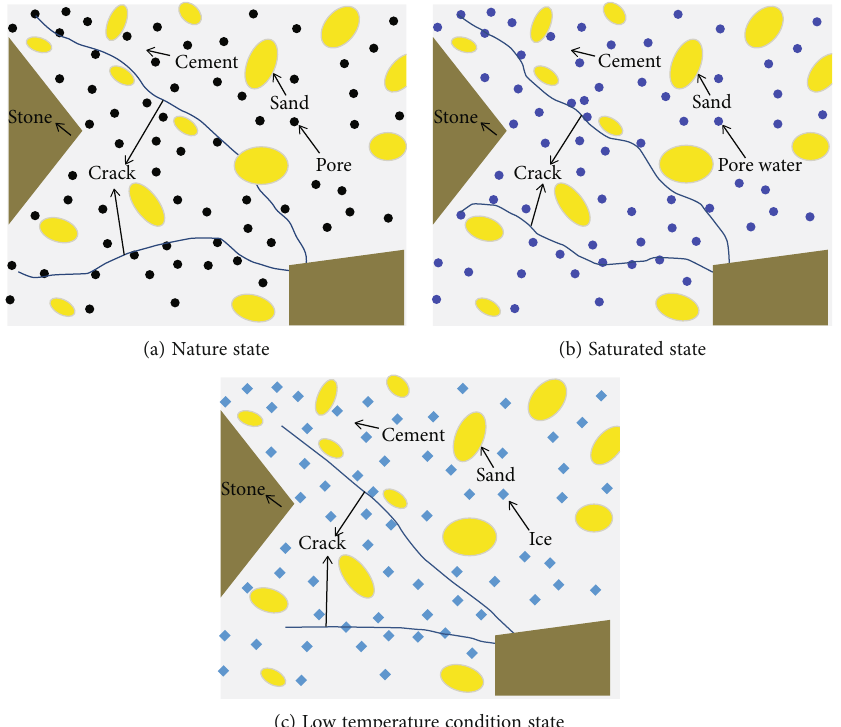
Figure 10: Schematic diagram of failure model of water-saturated concrete.